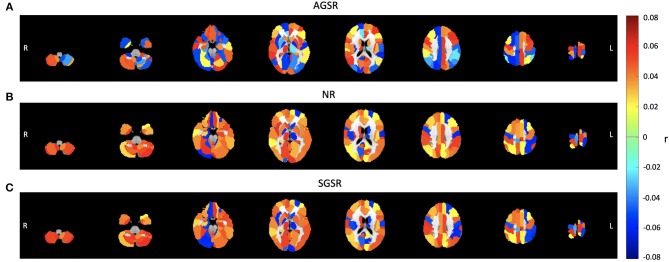
Comparing the average functional connectivity between the PCC ROI as a seed region and the brain ROIs using the AAL 116 atlas for fMRI data of all subjects. The average functional connectivity applying (A) AGSR, (B) NR, and (C) SGSR. Slices shown in the maps are at Z = 09, 15, 25, 35, 45, 55, 65, 75, respectively. AGSR, Adaptive Global Signal Regression; NR, No Regression; SGSR, Static (conventional) Global signal regression.